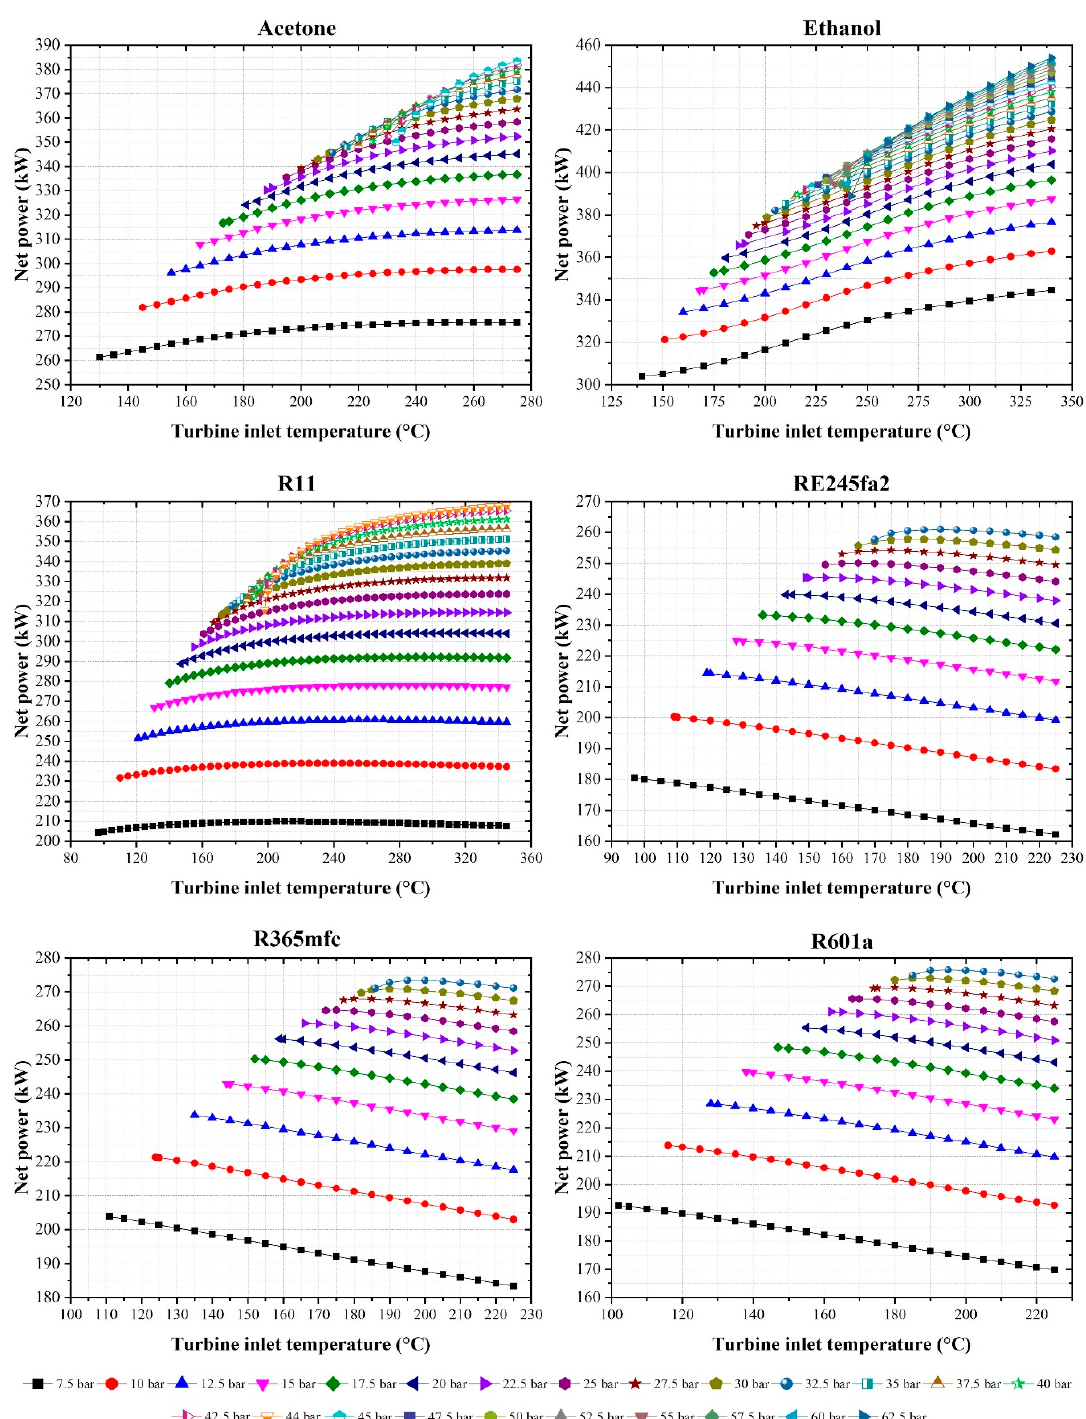
Figure 5. The net power evaluated from the ORC for varying turbine inlet temperatures and turbine inlet pressures.